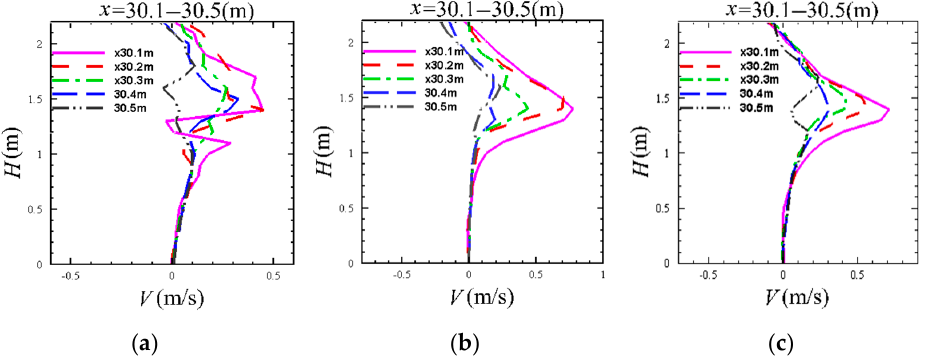
Figure 19. Vertical velocity distribution of the flow field inside and directly above the pore structure when the porosity is 0.5, 0.25 and 0.125 and x = 30.1–30.5 m. ( a ) n w = 0.5; ( b ) n w = 0.25; ( c ) n w = 0.125.